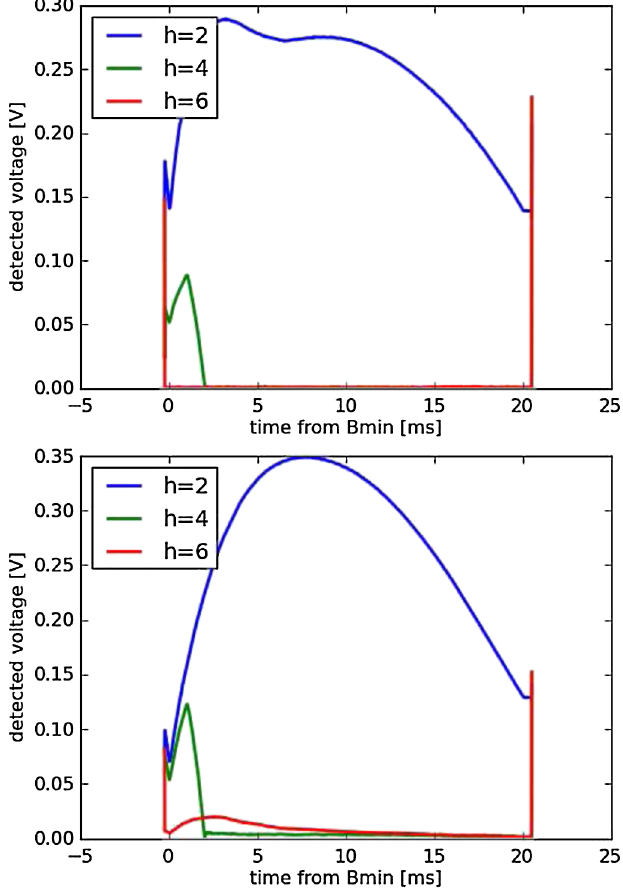
FIG. 12. Step 1 example (cavity #1). The harmonic compo- nents of (top) the LLRF driving rf and (bottom) the cavity voltage are